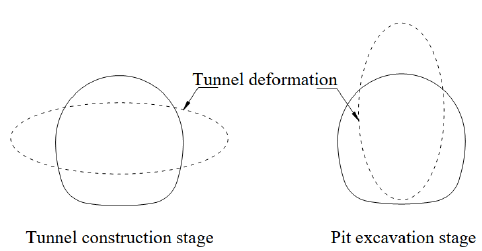
Figure 14. Tunnel deformation diagram.